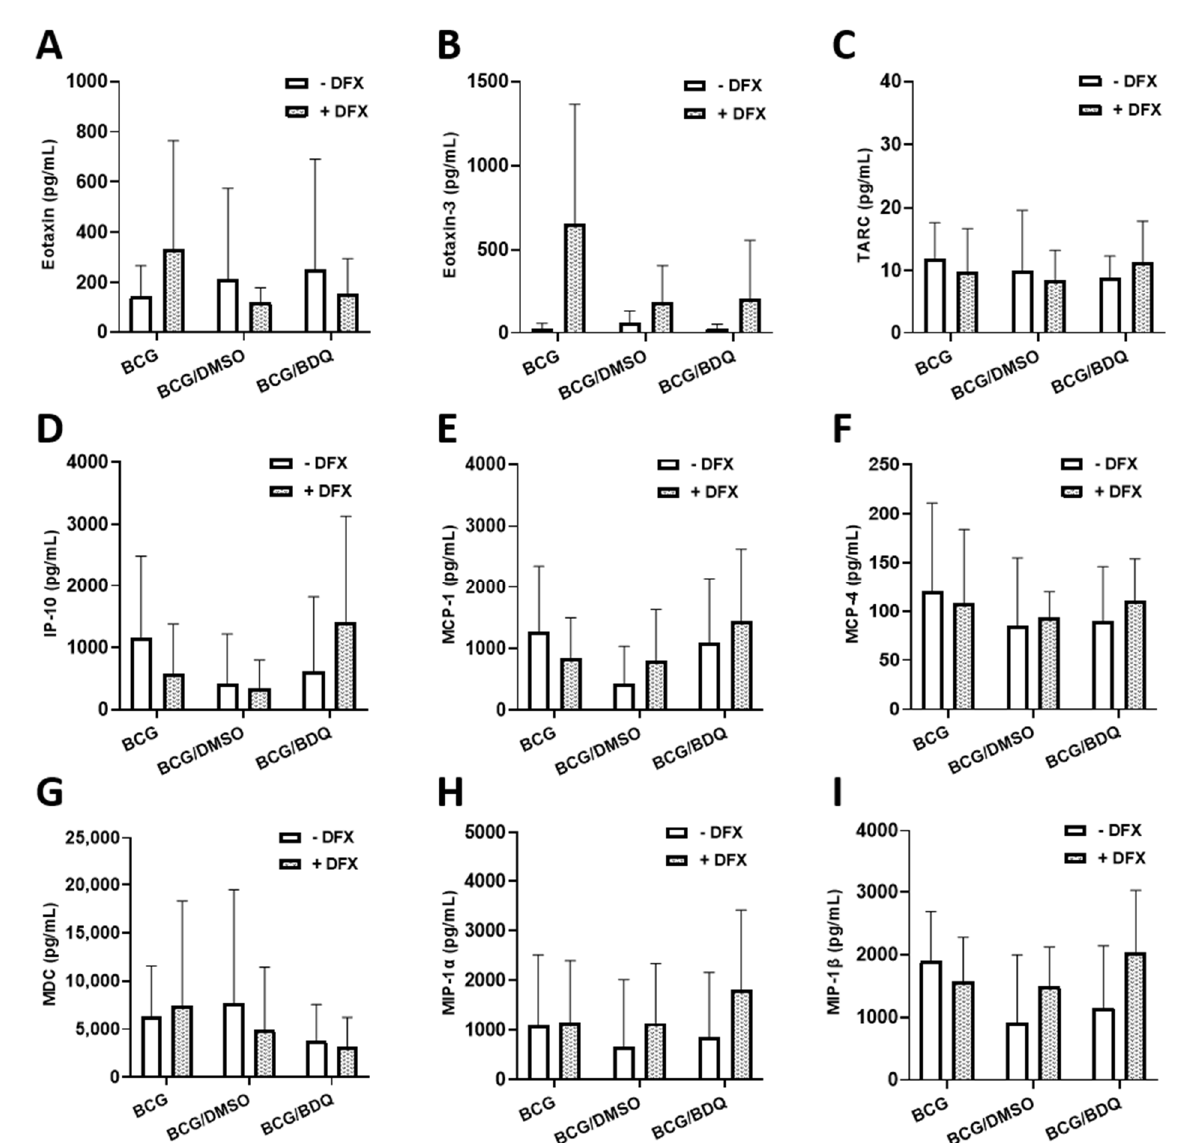
Figure 3. Assessing if dual DFX-bedaquiline treatment affects chemokine secretions in BCG-infected hMDMs. hMDMs, obtained from healthy blood donors, were infected with BCG for three hours and were subsequently treated with DFX (100 µM) in combination with bedaquiline (0.5 µg/mL). Twenty-four hours post BCG infection, cell supernatants were collected and levels of ( A ) eotaxin, ( B ) eotaxin-3, ( C ) TARC, ( D ) IP-10, ( E ) MCP-1, ( F ) MCP-4, ( G ) MDC, ( H ) MIP-1 α and ( I ) MIP-1 β were quantified using Meso Scale Discovery Multi-Array technology ( n = 5). Bars denote mean ± SEM. p > 0.05 (Two-way repeated measures ANOVA tests with Šídák’s multiple comparisons tests).